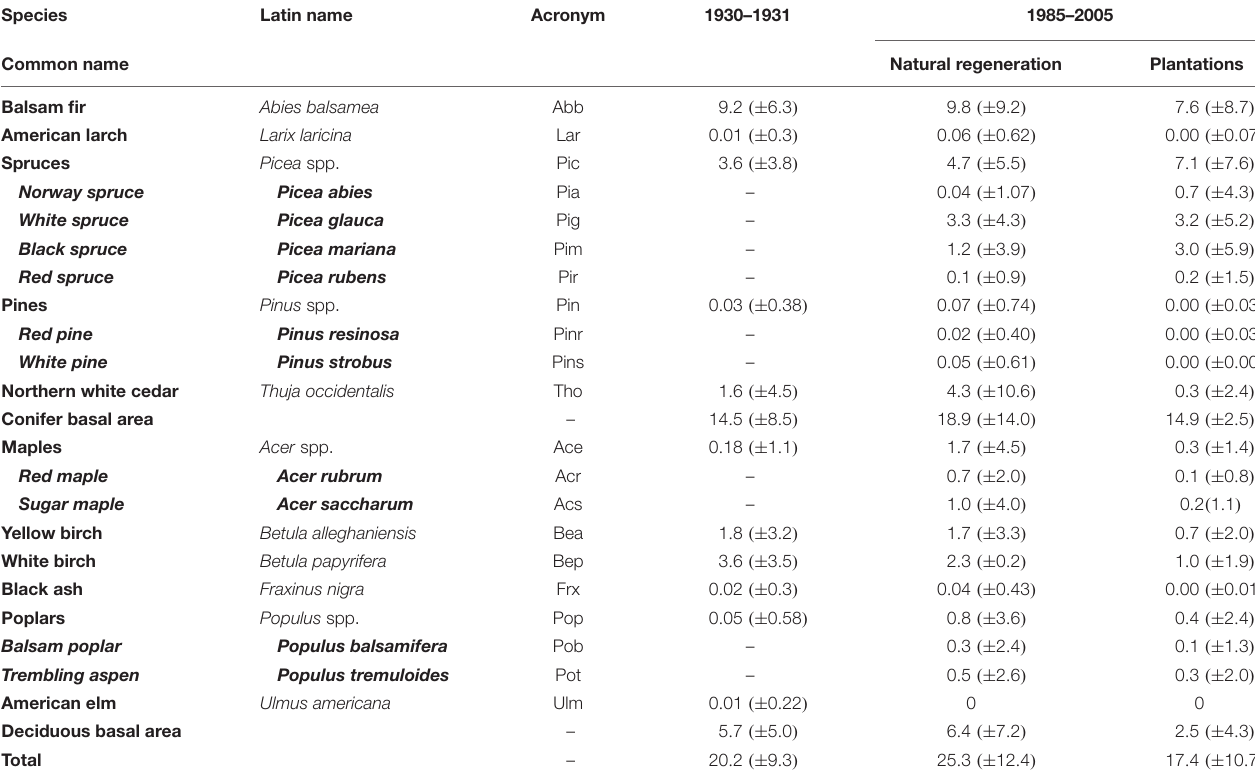
TABLE 6 | Taxa basal area (m2/ha ± sd) in 1930–1931 ( N = 16804) and 1985–2005 for the whole study